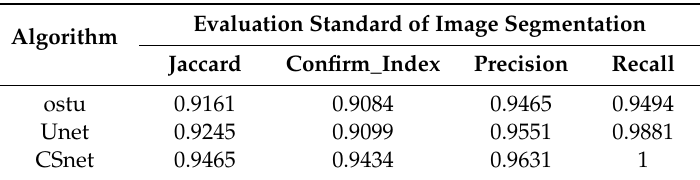
Table 1. Comparation of algorithm results.